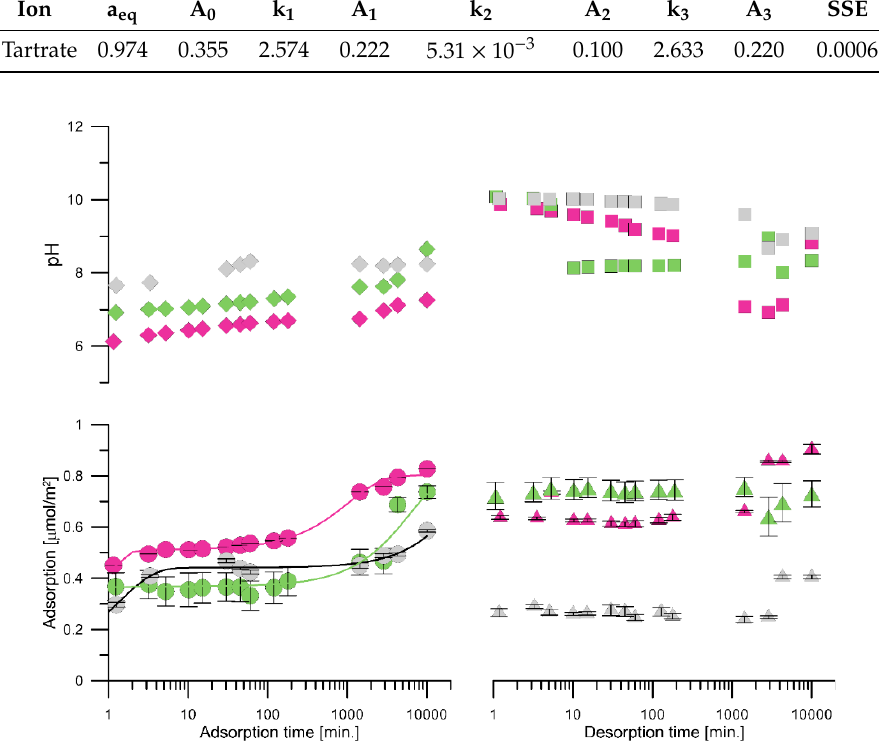
Table 2. Parameters of the multiexponential equation fitted to the data of adsorption kinetics of oxalate, citrate and tartrate ions from the solutions of the initial concentration 0.000001 mol / dm 3 on the hydroxyapatite.